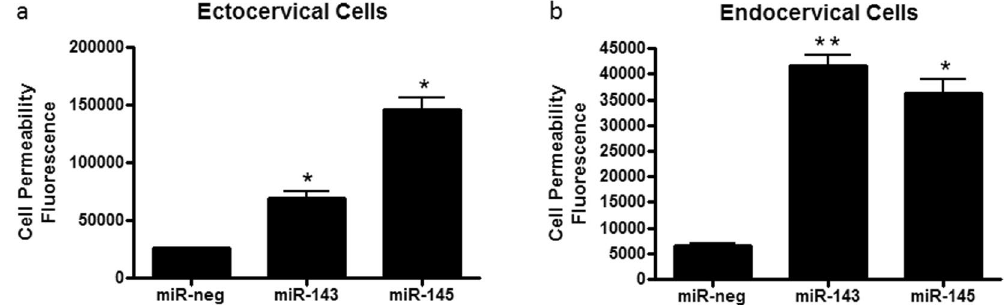
Figure 1. Epithelial cell permeability is altered in ectocervical and endocervical cells transfected with miR- 143 and miR-145 mimics. Epithelial cell permeability was significantly increased in ectocervical cells ( a ) and endocervical cells ( b ) overexpressing miR-143 and miR-145 when compared to miR-negative (miR-neg) control. Cell permeability is expressed as fluorescence OD measurements from a fluorescent plate reader and is indicative of the movement of FITC-dextran from the top to the bottom insert of a transwell chamber system. Values are mean ± SEM. * p < 0.001, ** p <